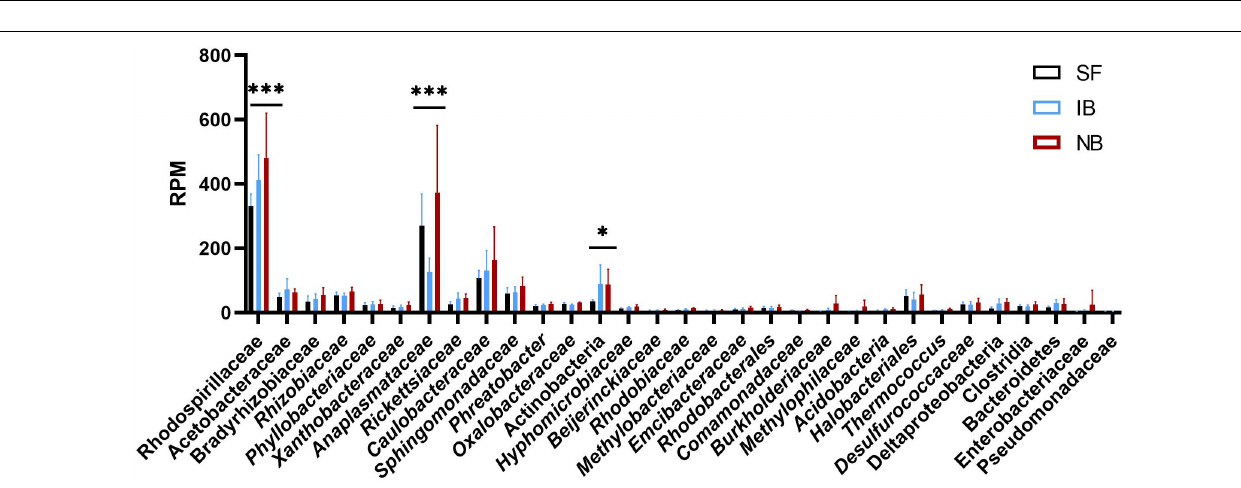
FIGURE 6 | Composition of the Ae. albopictus bacteriome after feeding with sugar, inactivated blood, and normal blood. ∗ P < 0.05, ∗∗∗ P < 0.001;